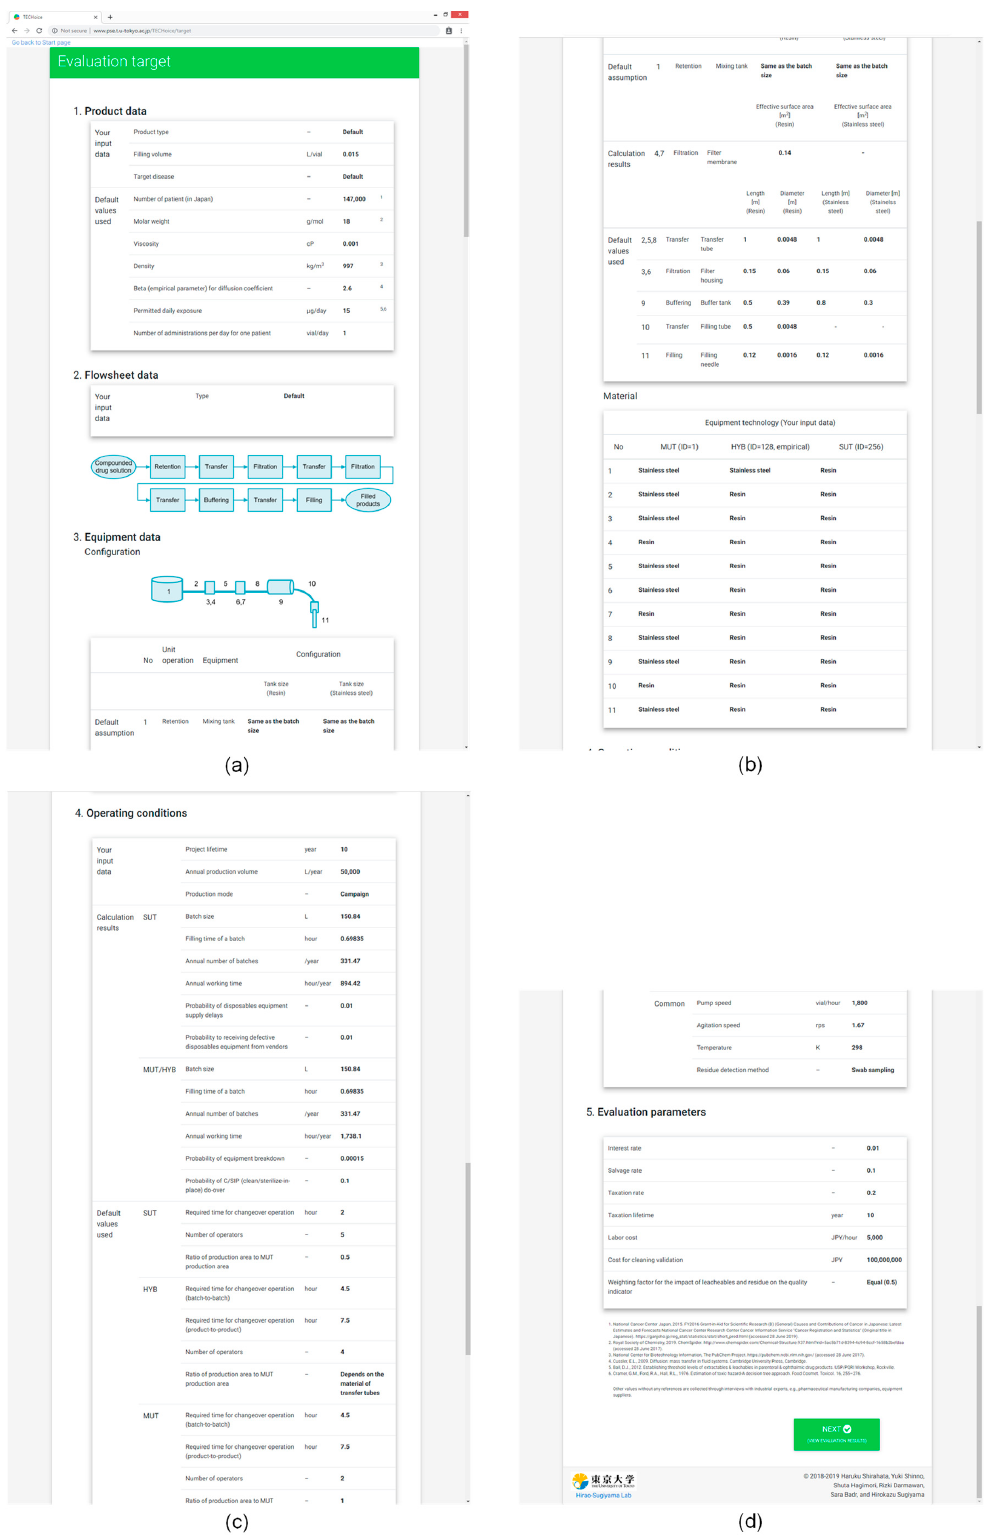
Figure A3. ( a–d ) Screenshot of the third page (Evaluation target) of “ TECH oice”.